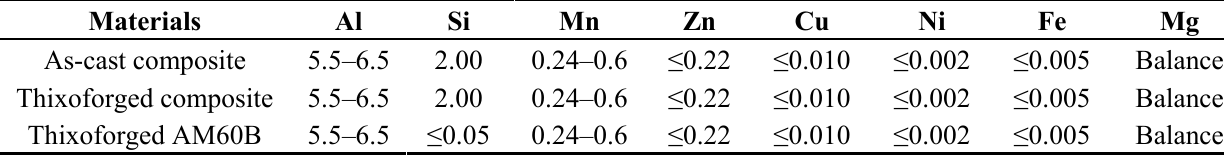
Table 1. Chemical composition (in wt%) of the materials